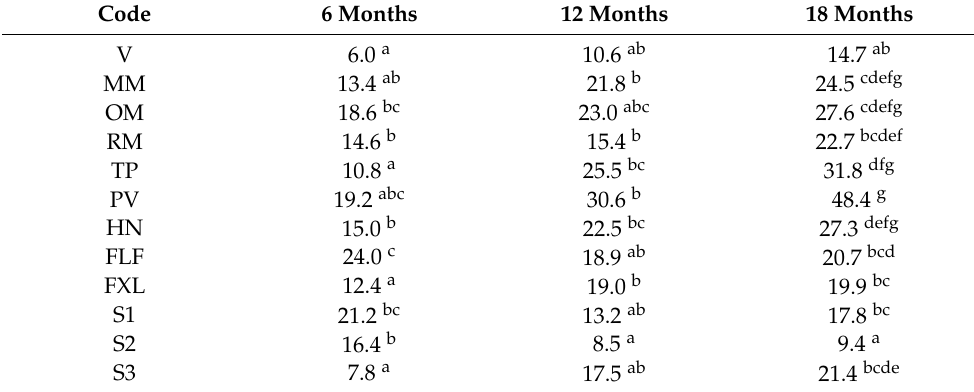
means, “c”, larger still means, and so on).